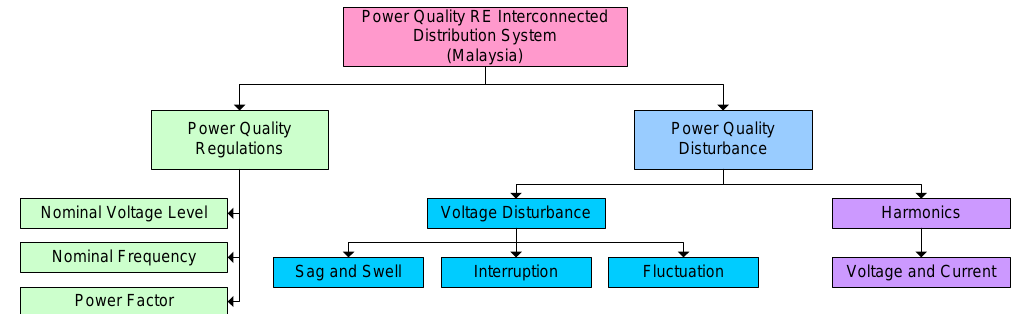
Figure 5. Common power quality regulations and disturbances within an RE interconnected Malaysian distribution system.